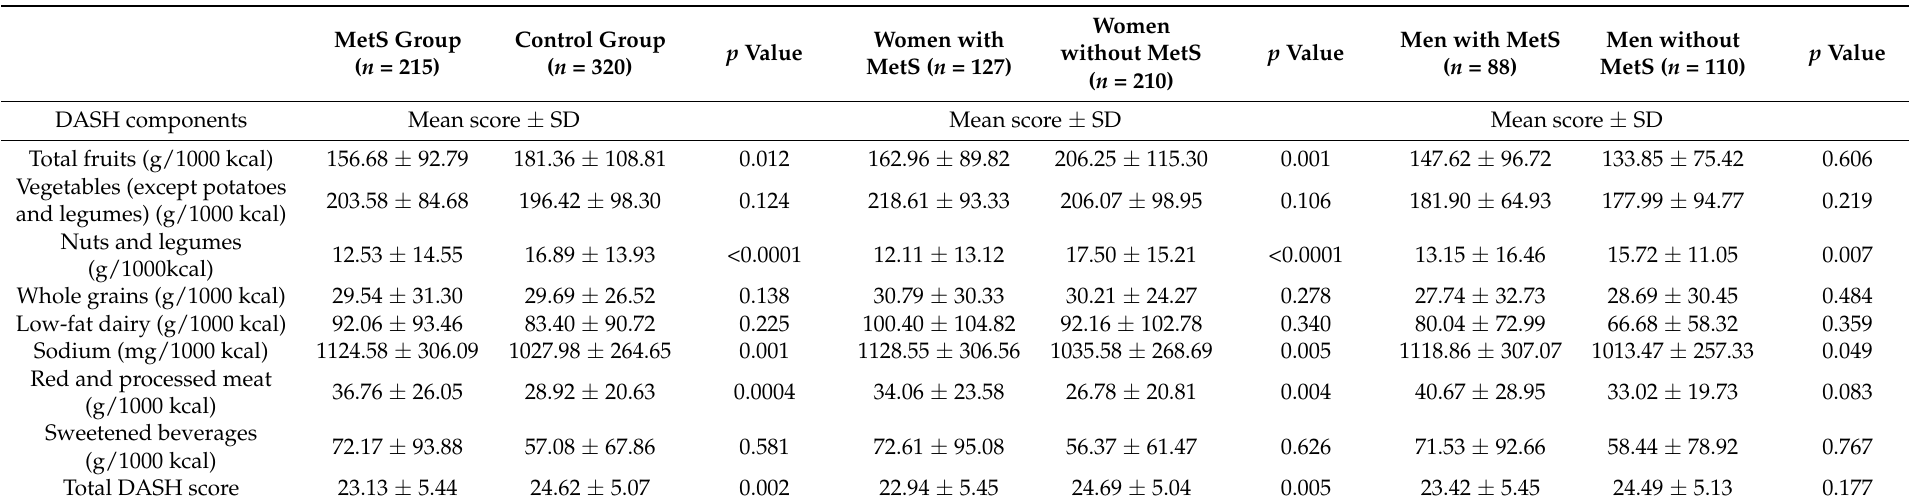
Table 2. DASH component scores for MetS group and control group and women and men with and without